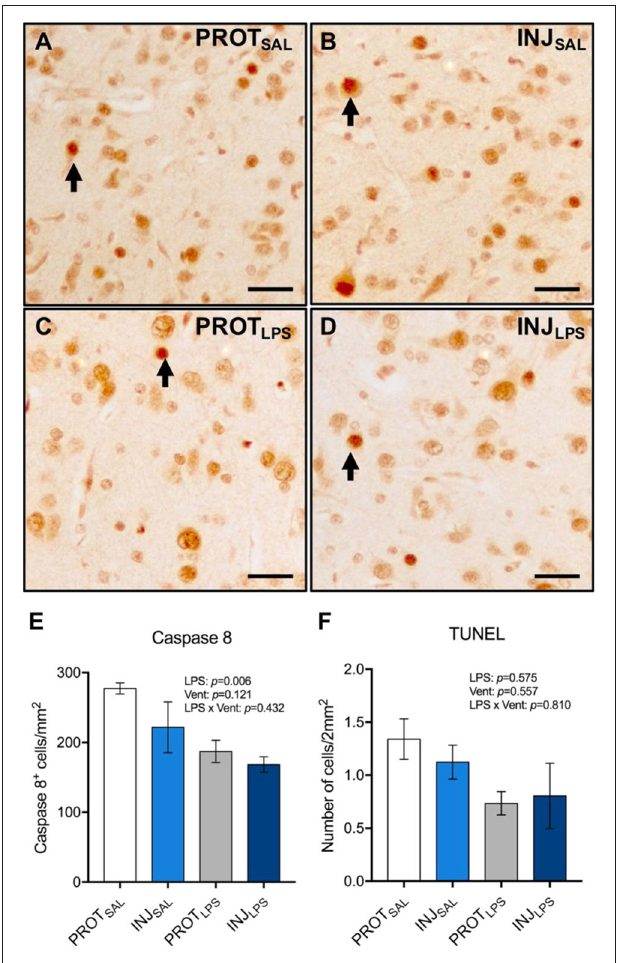
FIGURE 4 | Ventilation strategy and LPS exposure did not induce apoptosis in cortical gray matter. Representative images of Caspase 8 + cells in the gray matter (A–D) . A significant reduction in the number of Caspase 8 + cells was observed in the LPS-treated groups compared to the respective saline controls (E) . No significant differences in the number of TUNEL + cells were observed between the groups (F) . Magnification = 8x, scale bar = 20 µ m. PROT SAL , N = 5; PROT LPS , N = 6; INJ SAL , N = 6; and INJ LPS , N = 5.